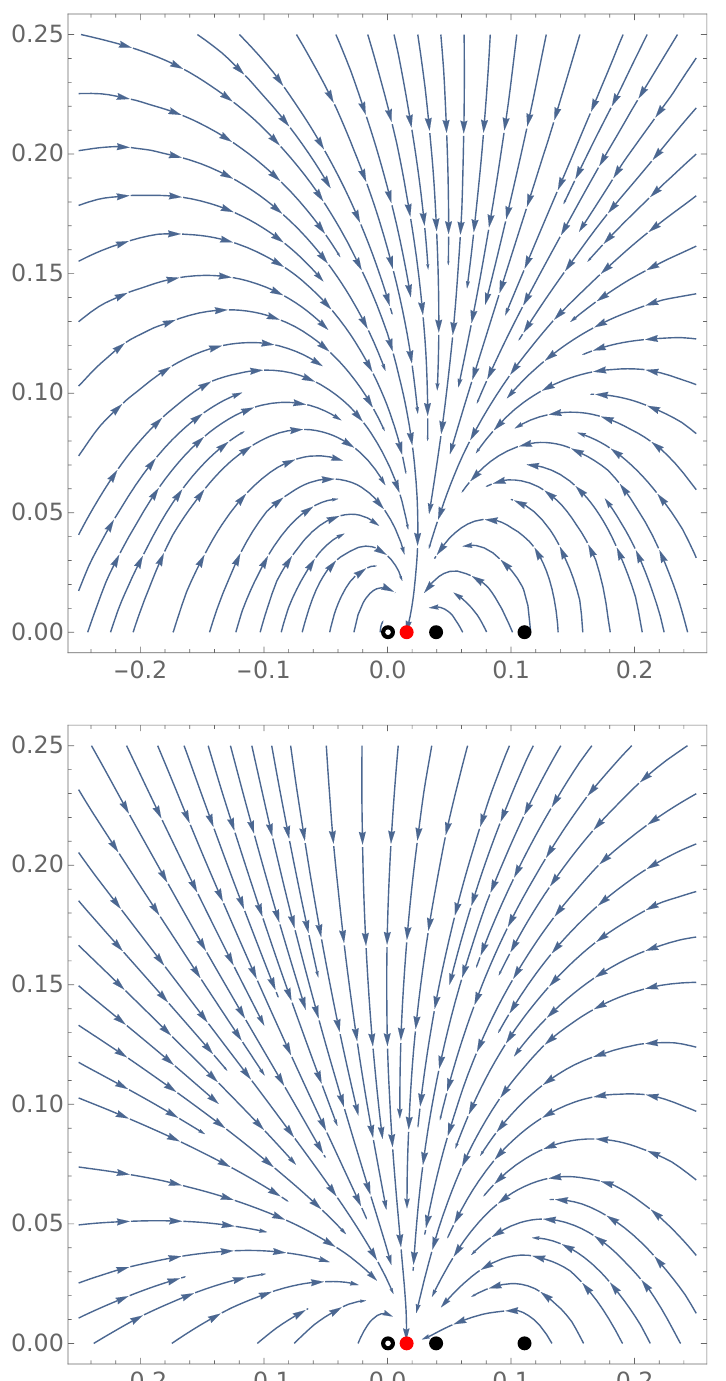
Figure 7 . The (cid:13)ows for ’ = ’ ( (cid:26) ) for the charges Q = ( (cid:0) 2 ; 0 ; 0 ; 5) T (above) and Q = (0 ; 3 ; 1 ; 0) T p (below) leading to attractor point at ’ = 33 (cid:0) 8 17. The point of maximal unipotent monodromy at ’ = 0 is indicated by a hollow black dot while the solid black dots represent conifold singularities.